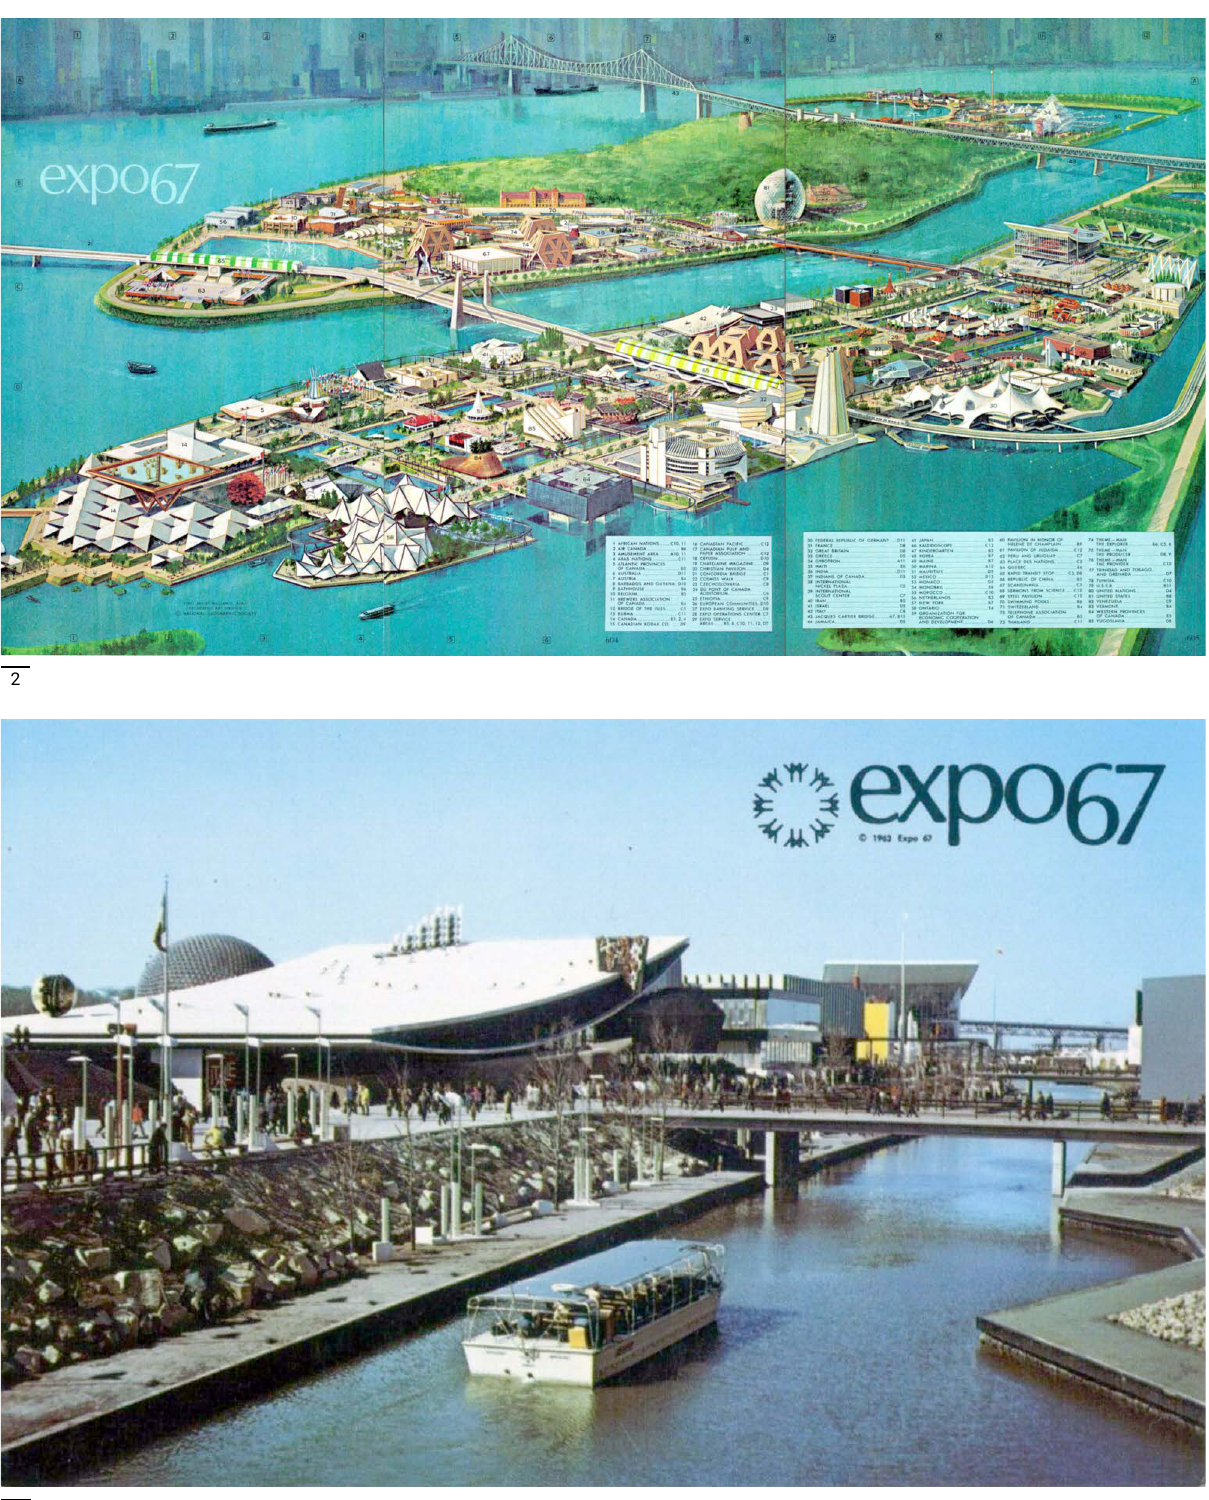
The Montreal Expo 1967 in an advertisement drawing of the time. The Italian pavilion (no. 42) is to the left of the United States pavilion (no. 81) and the Soviet Union pavilion (no. 79), located opposite each other but on two different islands.